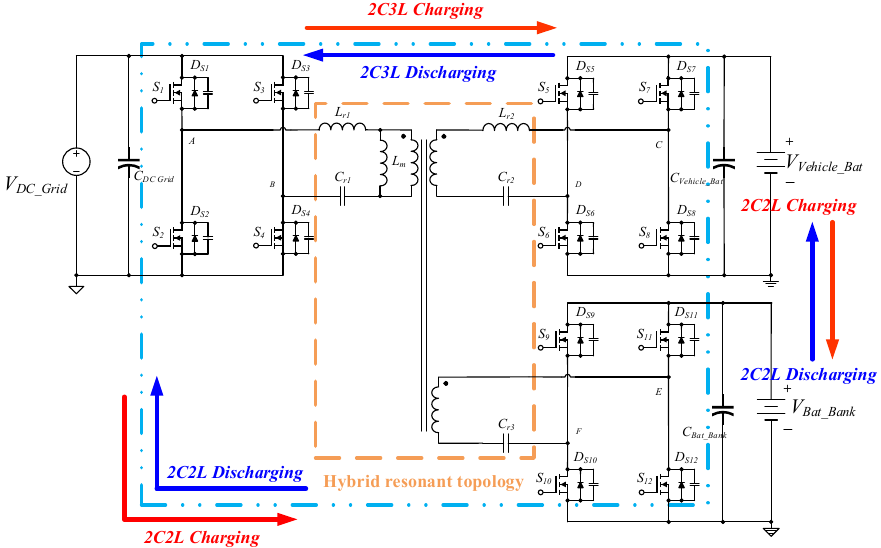
Table 1. Six power conversion modes of the converter.